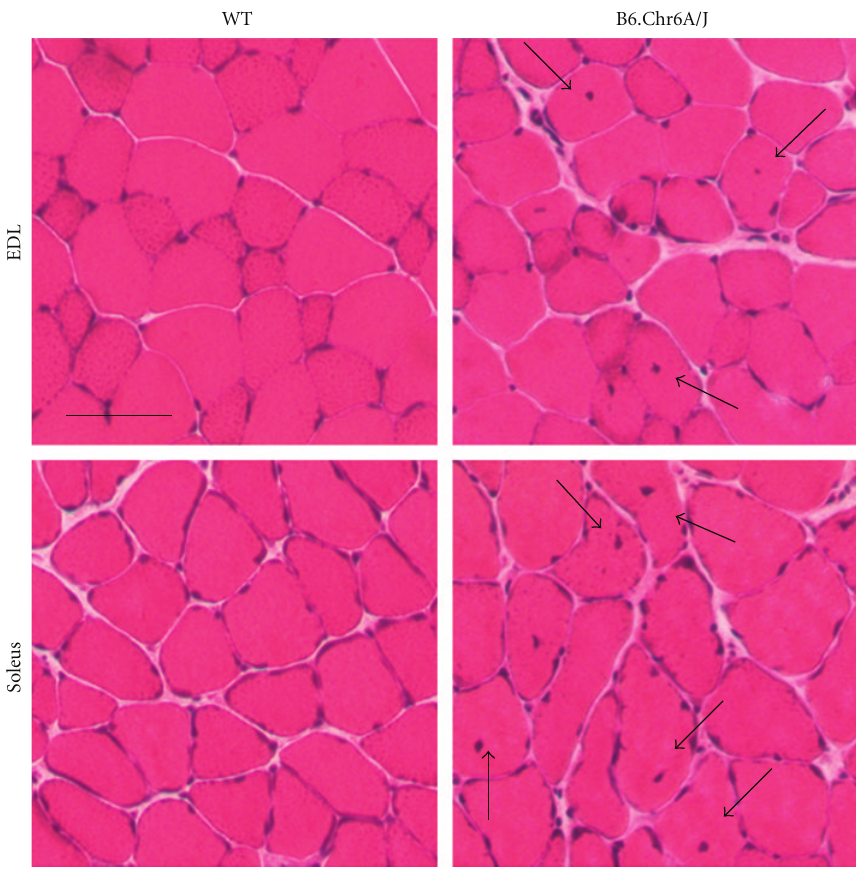
Figure 3: Histology examination of EDL and soleus muscles from C57BL/6J-Chr6 A / J /NaJ mice. H&E-stained EDL (top panel) and soleus (bottom panel) muscle sections of C57BL/6J (WT) and C57BL/6J-Chr6 A / J /NaJ mice. Scale bar: 100 μ